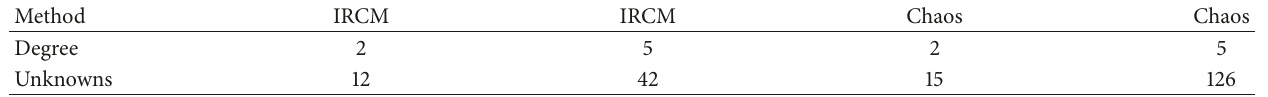
Figure 6: (a) Standard deviation of solution where 𝜉 0 and 𝜉 2 are truncated normal variables in [−4,4] , 𝜉 1 is a uniform variable in [−1,1] , and 𝜉 [0, 10] and 𝜎 𝜉 𝜉 3 is a truncated exponential variable in 𝑖 = 20%. (b) Means of solution where 0 and 2 are truncated normal variables in 𝜉 [−1,1] , and 𝜉 [0, 10] and 𝜎 1 is a uniform variable in 3 is a truncated exponential variable in 𝑖 = 20%. Table 5: Number of coefficients to compute for IRCM and PC at degrees 2 and 5.